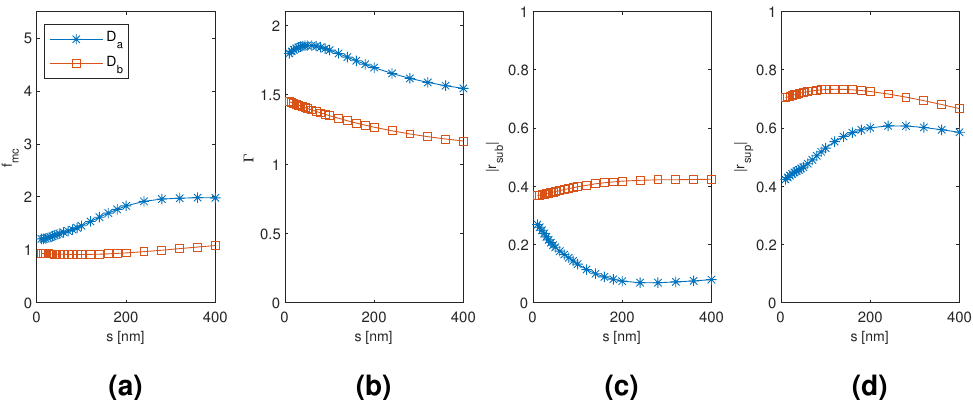
Figure 6. The results for the nanowire dimer D a and D b mode as a function of the separation of the nanowires with the diameter of the nanowires corresponding to the point of modal cost function minimum for each mode (as listed in Table 1). ( a ) modal cost function value; ( b ) modal confinement factor; ( c ) substrate modal reflection coefficient magnitude; ( d ) superstrate modal reflection coefficient